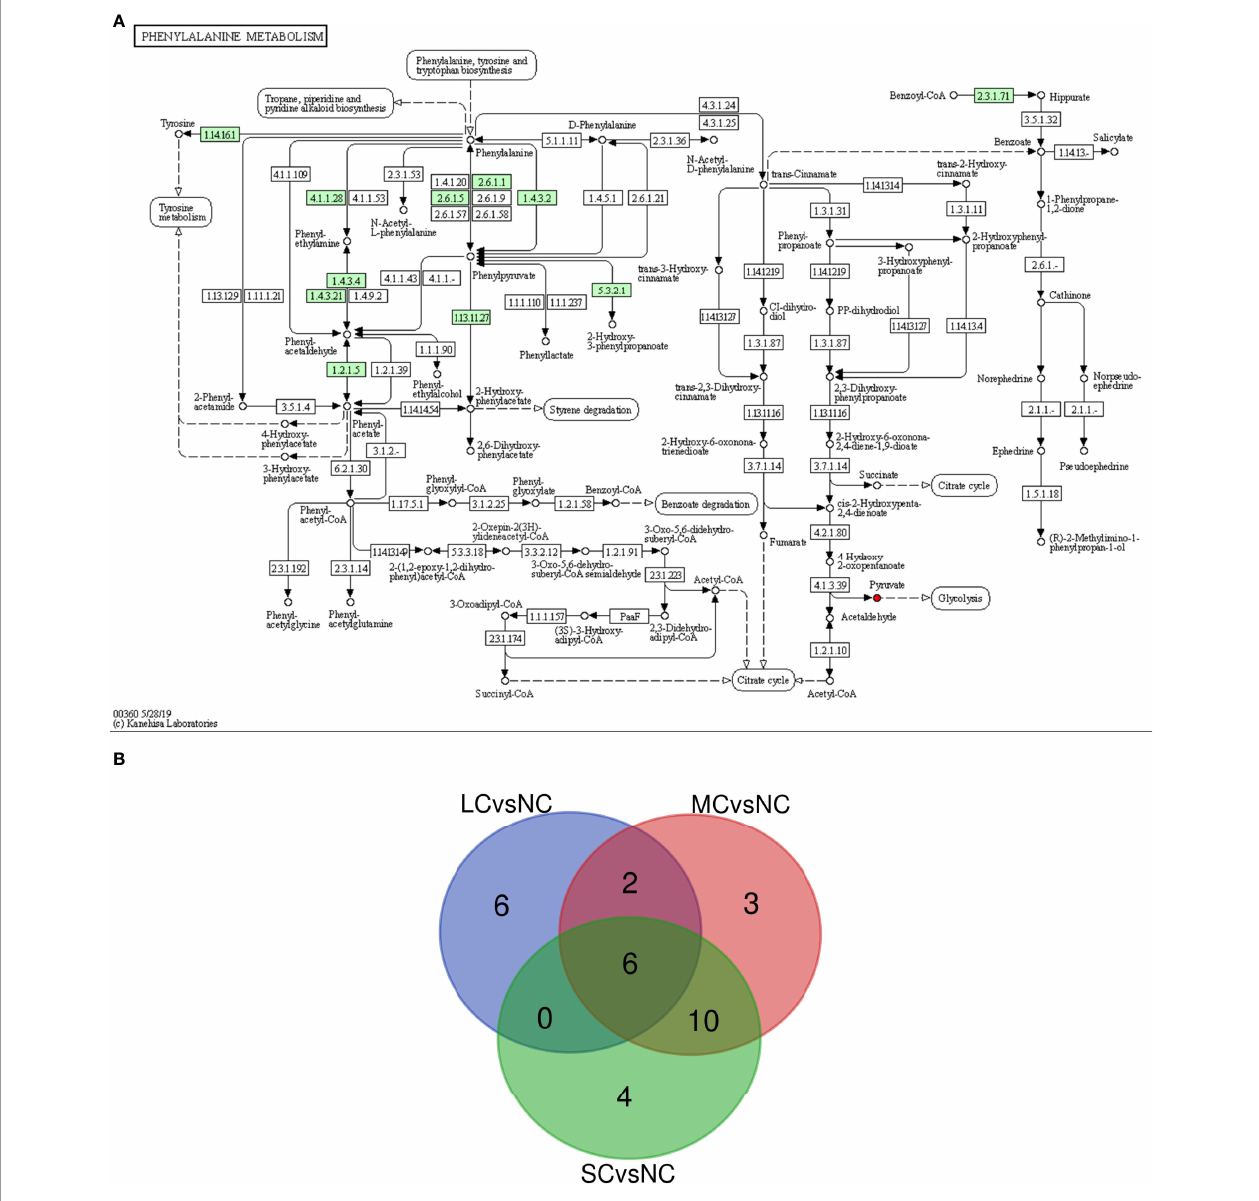
FIGURE 7 | Phenylalanine metabolic pathway (A) and Venn diagram of mutual signi fi cant metabolic pathways (B) . In a, “ ! ” indicates the reaction direction, the small box indicates the enzyme activity, the small circle indicates the compound, the red indicates the up-regulated compound, the blue indicates the down-regulated compound, the large round box indicates the other metabolic pathway, and the dotted arrow indicates the relationship with other metabolic pathways, small green squares indicate enzymes unique to the species. In b, Green circle represents SCvsNC group, red circle represents MCvsNC group, blue circle represents LCvsNC group, the number in the fi gure represents the amount of different metabolites after